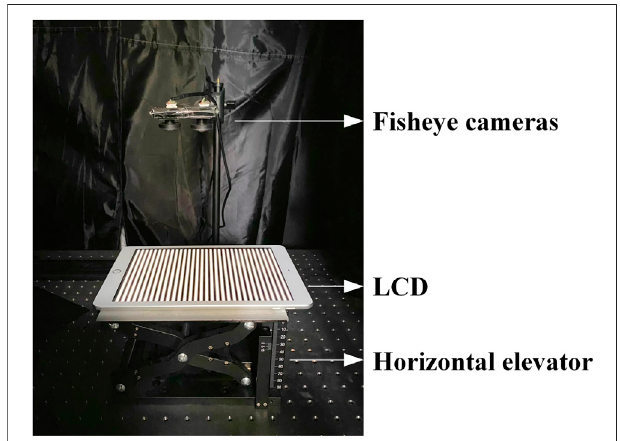
FIGURE 5 | Experiment